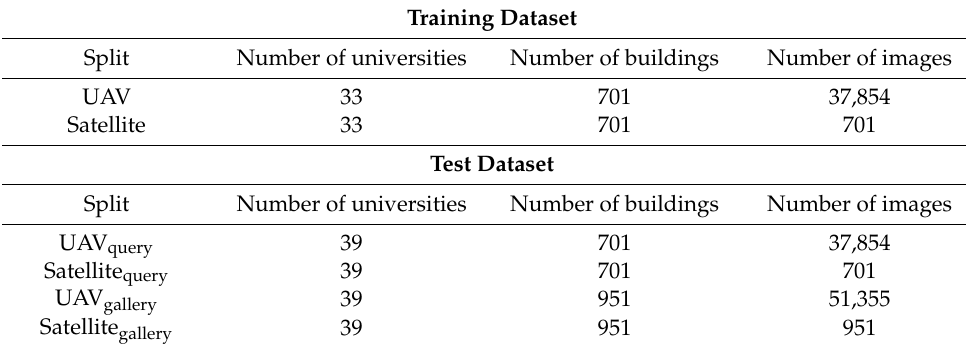
Table 1. Experimental data division